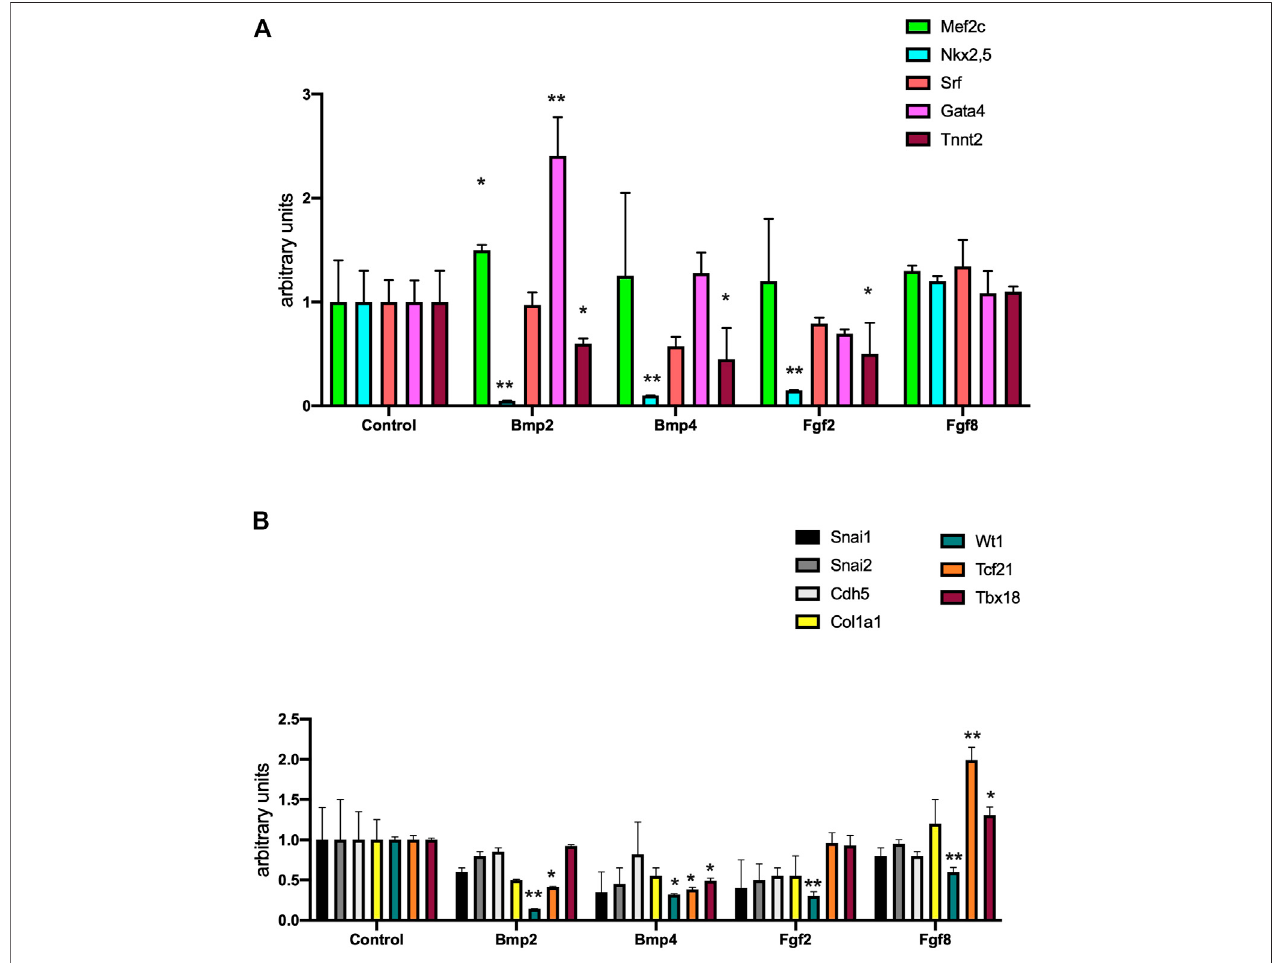
FIGURE3| Panel (A) RT-qPCRanalysesofMef2c,Nkx2.5,Srf,Gata4andTnnt2expressionaftercontrol,Bmp2,Bmp4,Fgf2andFgf8treatments,respectively,to mouse E9.5 PE/ST explants. Panel (B) RT-qPCR analyses of Snai1, Sna2, Cdh5, Col1a1, Wt1, Tcf21 and Tbx18 expression after control, Bmp2, Bmp4, Fgf2 and Fgf8 treatments, respectively, to mouse E9.5 PE/ST explants. * p < 0.05, ** p < 0.01, *** p < 0.001, **** p <